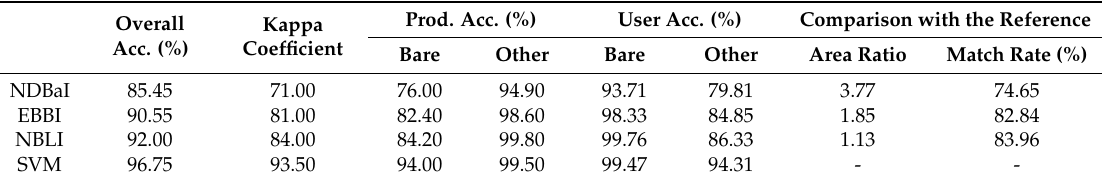
Figure 7. Distributions of e bare land extracted from index images: ( a ) the NDBaI result; ( b ) EBBI result; ( c ) NBLI result; ( d ) NBLI result without water removal; ( e ) water bodies extracted with MNDWI; and ( f ) the supervised classification result. Blue polygons represent the loop roads. Table 2. Accuracy